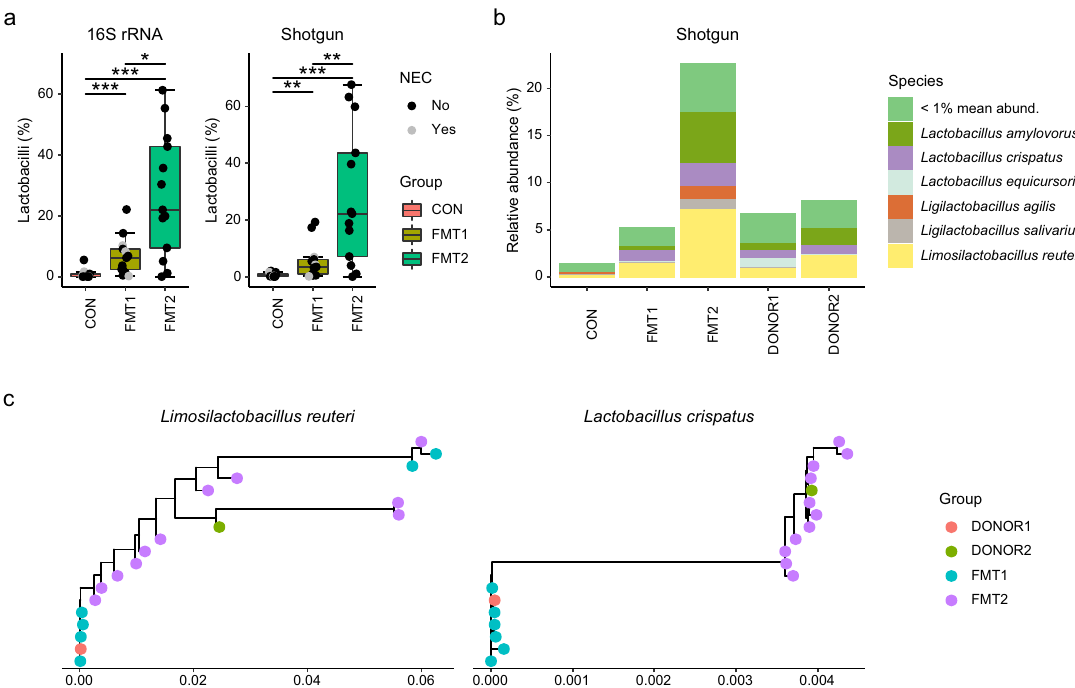
Fig. 5 Engrafted lactobacilli strains differed according to the respective donors. The relative abundance (a) and dominant species (b) of lactobacilli, and strain tracking of Lmb. reuteri and Lb. crispatus by StrainPhlAn (c). Lactobacilli with minimum mean relative abundance of 1% are shown. The labels of *, ** and *** represent adjusted p < 0.05, 0.01 and 0.001 (Wilcoxon rank-sum test with Benjamin-Hochberg correction). Respectively n = 13, 13, 12 for FMT1, FMT2 and CON. In boxplots, the inner fences are depicted as error bars. FMT1 rectal FMT with Donor 1, FMT2 rectal FMT with Donor 2, CON rectal FMT with sterile saline as control, 16S rRNA 16S ribosome RNA amplicon sequencing, Shotgun Shotgun metagenomics.